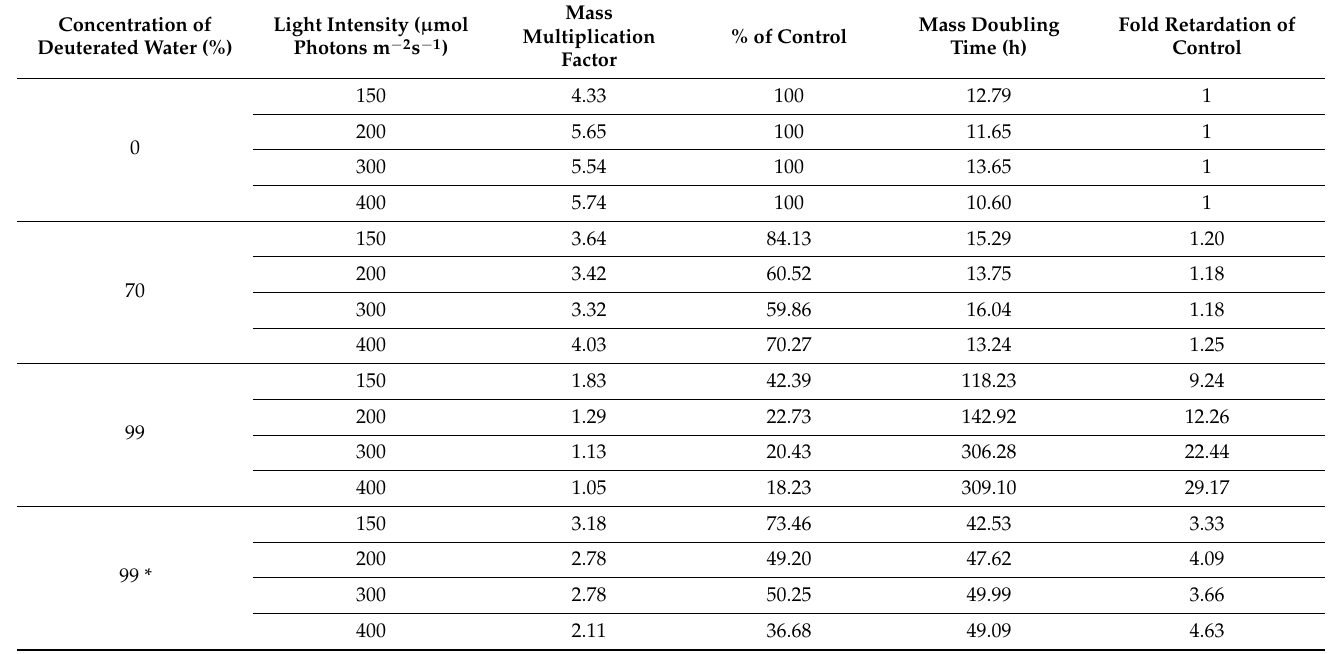
Table 2. Comparison of mass multiplication factor and mass doubling times for cultures grown in medium containing different concentrations of deuterated water at different light intensities. Average of at least three experiments is shown. Asterisk (*) denotes cultures pre-adapted for one week to given deuterated water